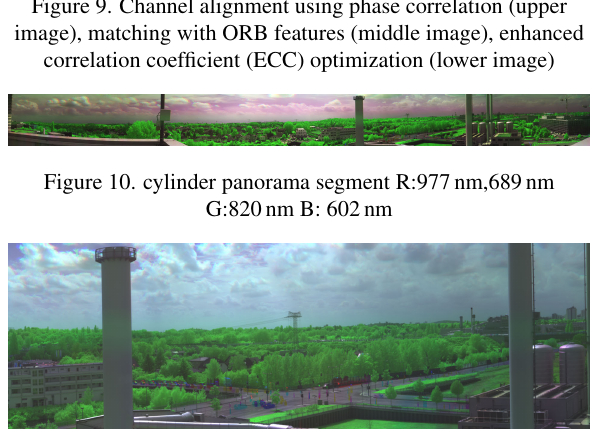
Figure 11. cylinder panorama segment R:977nm,689nm G:820nm B: 602nm